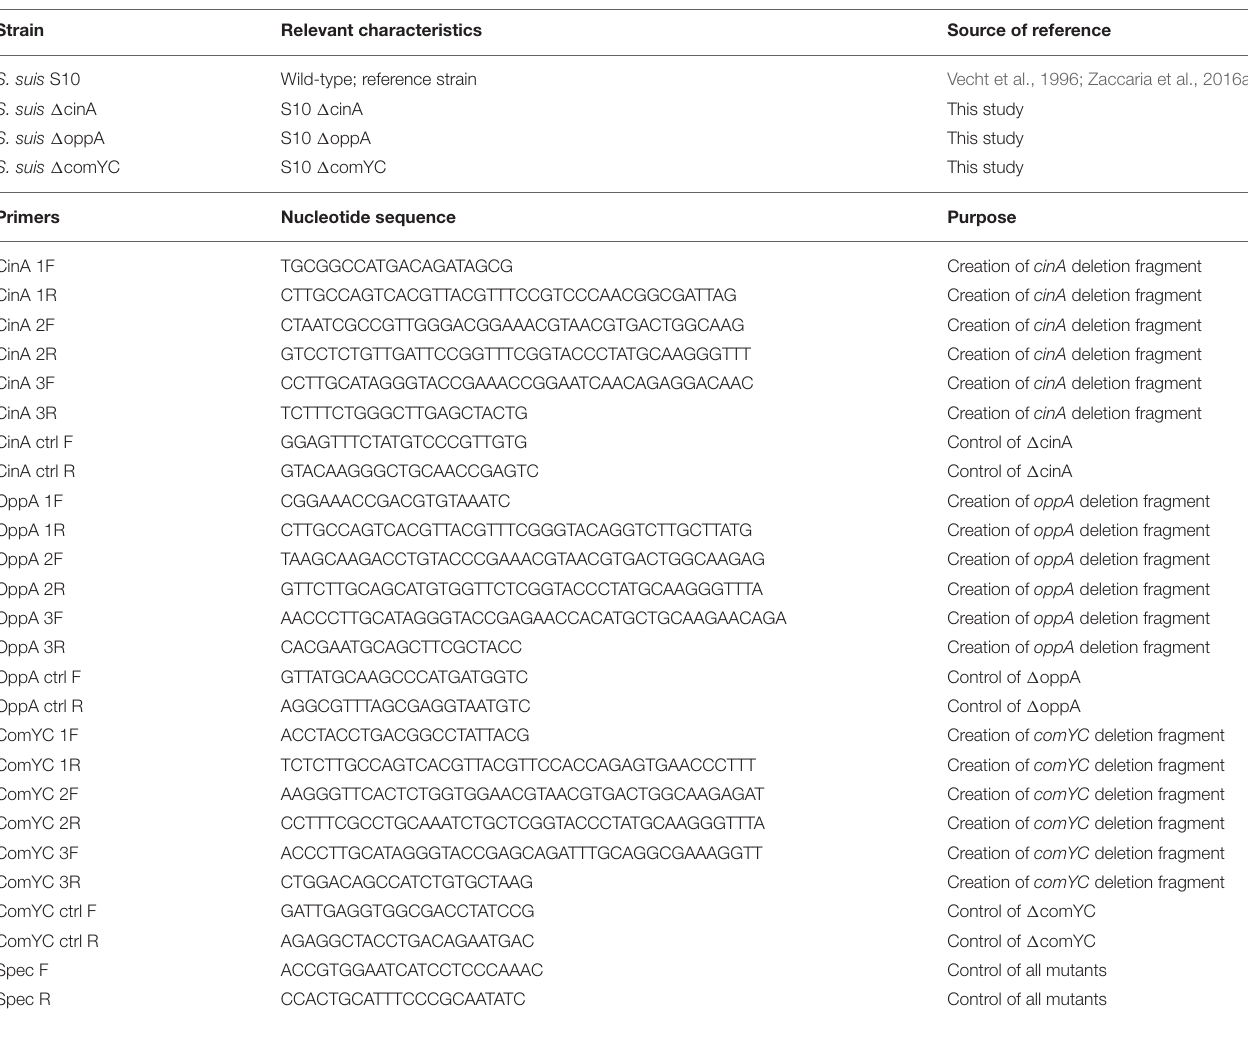
TABLE 1 | S . suis strains and primers